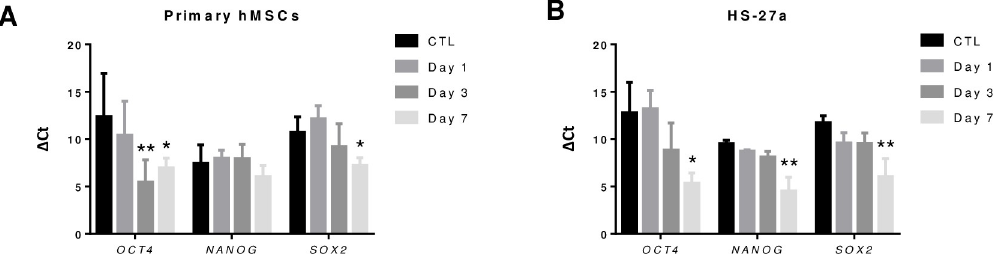
Fig 7. Dedifferentiation detection of hMSC- and HS-27a-spheroids over 7 days in culture. (A and B) Gene expression of OCT4 , NANOG and SOX2 for (A) primary hMSC- and (B) HS-27a-spheroids (primary hMSCs n = 5; HS-27a n = 3; � p � 0.05; �� p � 0.01).